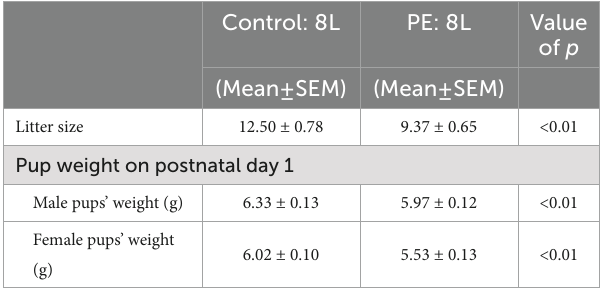
TABLE 1 Birth outcome.